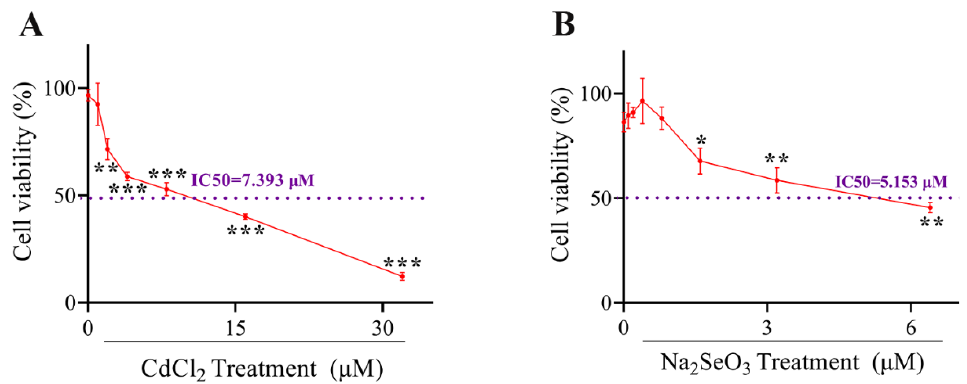
Figure 1 . The cells viabilities under Cadmium (Cd) or Selenium (Se) treatment. ( A ) The cells viability curve of hepatocytes exposed to CdCl 2 at different concentrations (0, 1, 2, 4, 8, 16 and 32 μ M) for 24 h. ( B ) The cells viability curve of hepatocytes exposed to Na 2 SeO 3 at different concentrations (0, 1, 2, 4, 8, 16 and 32 μ M) for 24 h. The data are expressed as mean ± SD. “*” indicates a significant difference compared with control group (* p < 0.05, ** p < 0.01 and *** p < 0.001).